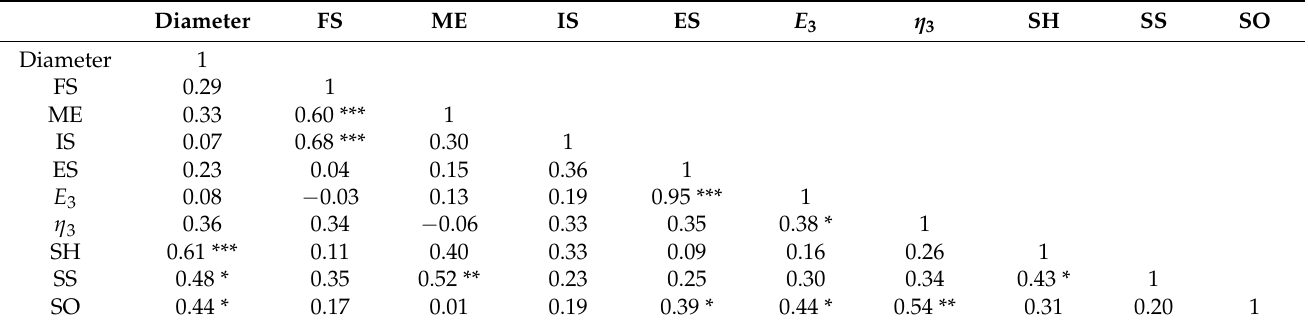
Table 5. Pearson correlation coefficients between mechanical and sensory test parameters. Diameter FS ME IS ES E 3 η 3 SH SS SO